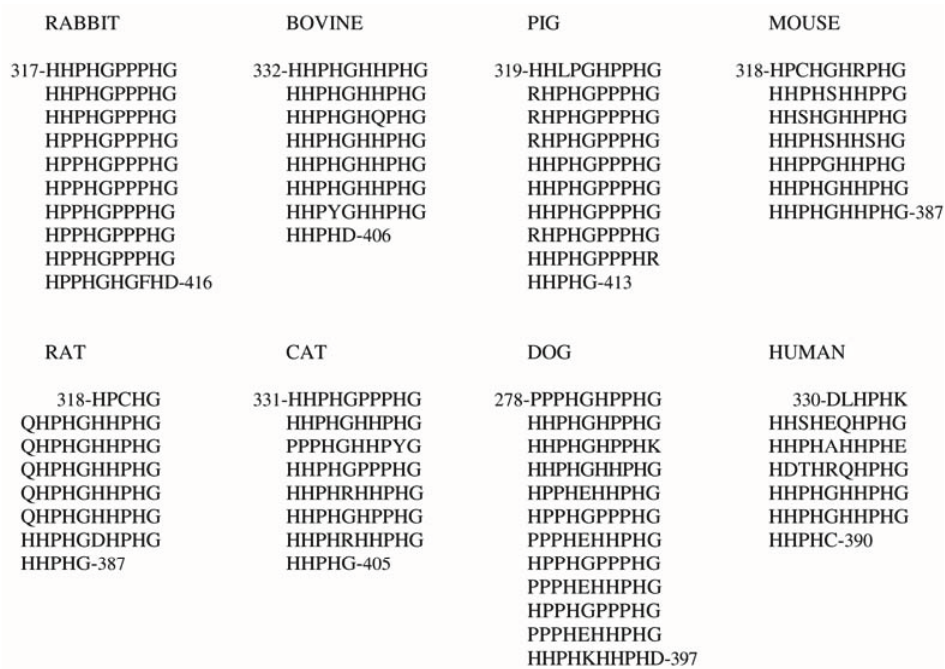
Figure 2. Tandem repeats of consensus decapeptide sequence found in the His-Pro-rich region of Histidine-Proline-Rich Glycoprotein (HPRG) from several mammalian